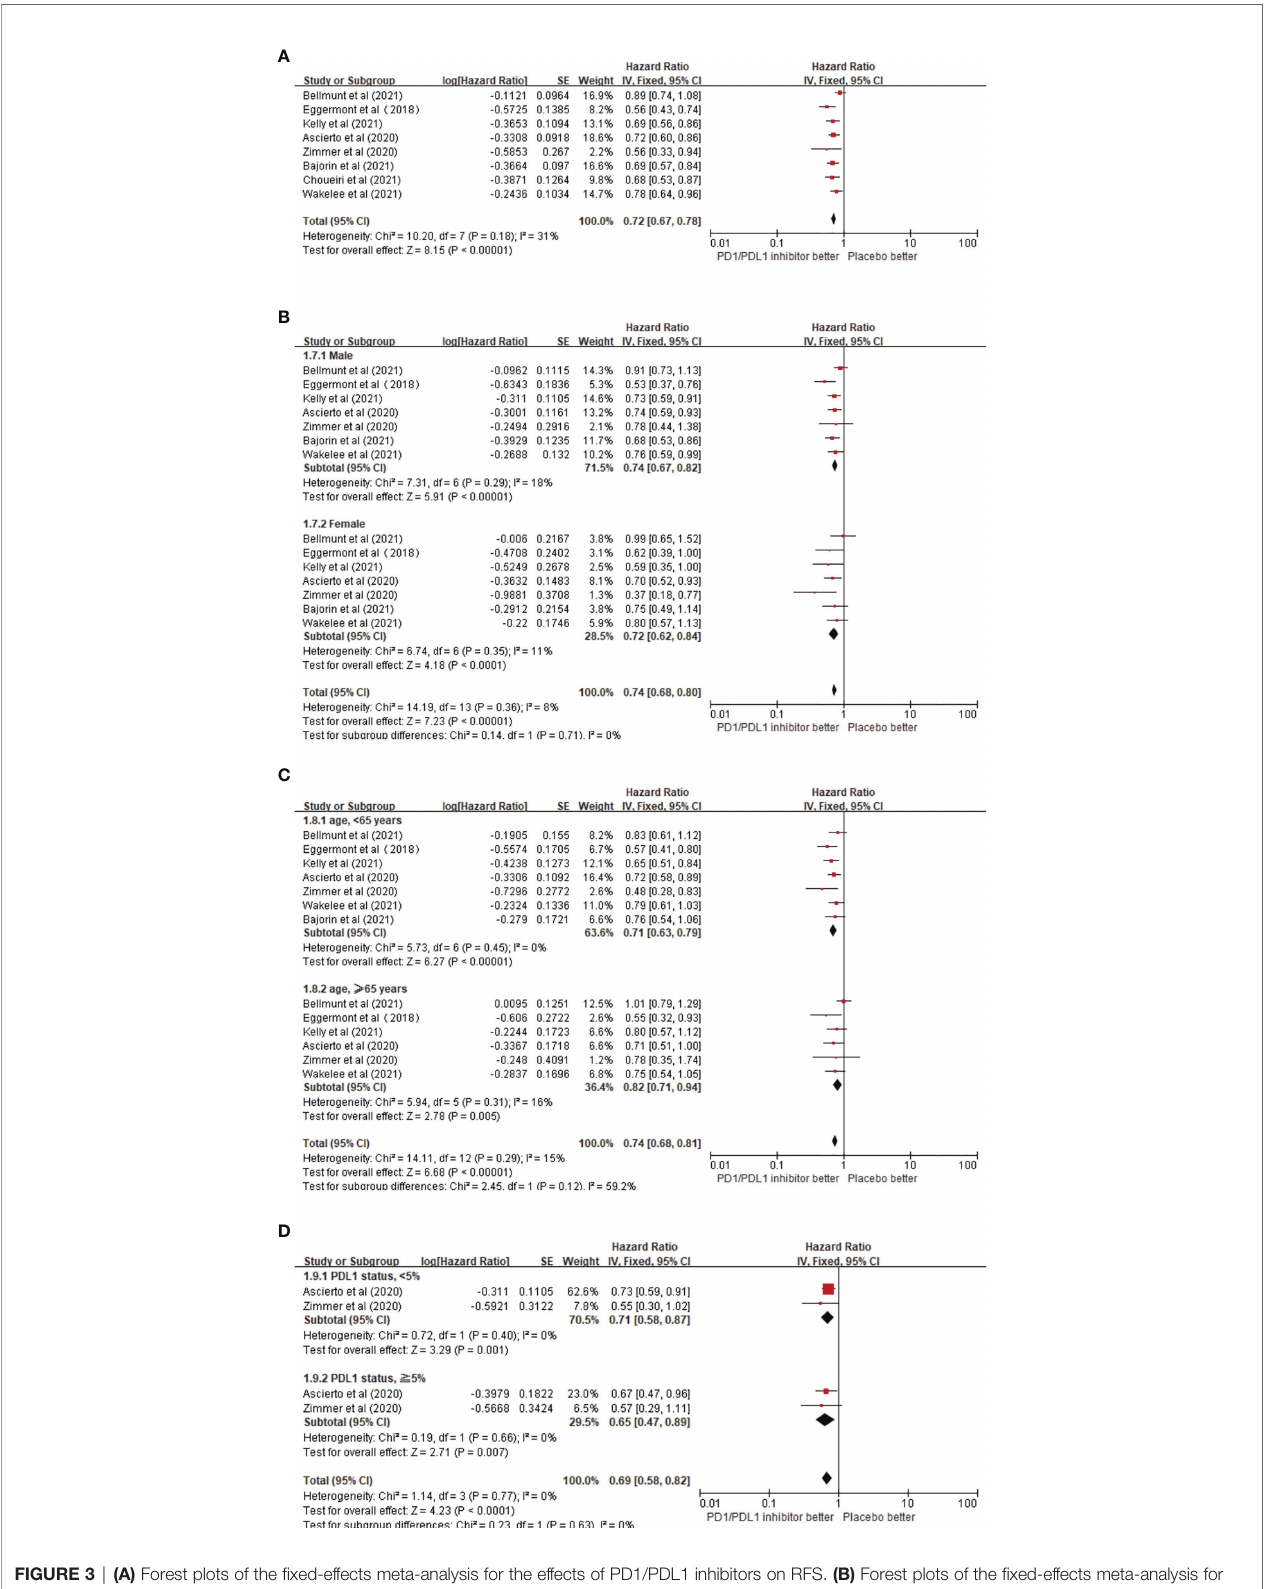
FIGURE 3 | (A) Forest plots of the fi xed-effects meta-analysis for the effects of PD1/PDL1 inhibitors on RFS. (B) Forest plots of the fi xed-effects meta-analysis for the effects of PD1/PDL1 inhibitors on PFS in gender. (C) Forest plots of the fi xed-effects meta-analysis for the effects of PD1/PDL1 inhibitors on RFS in different age group. (D) Forest plots of the fi xed-effects meta-analysis for the effects of PD1/PDL1 inhibitors on RFS in different PDL1